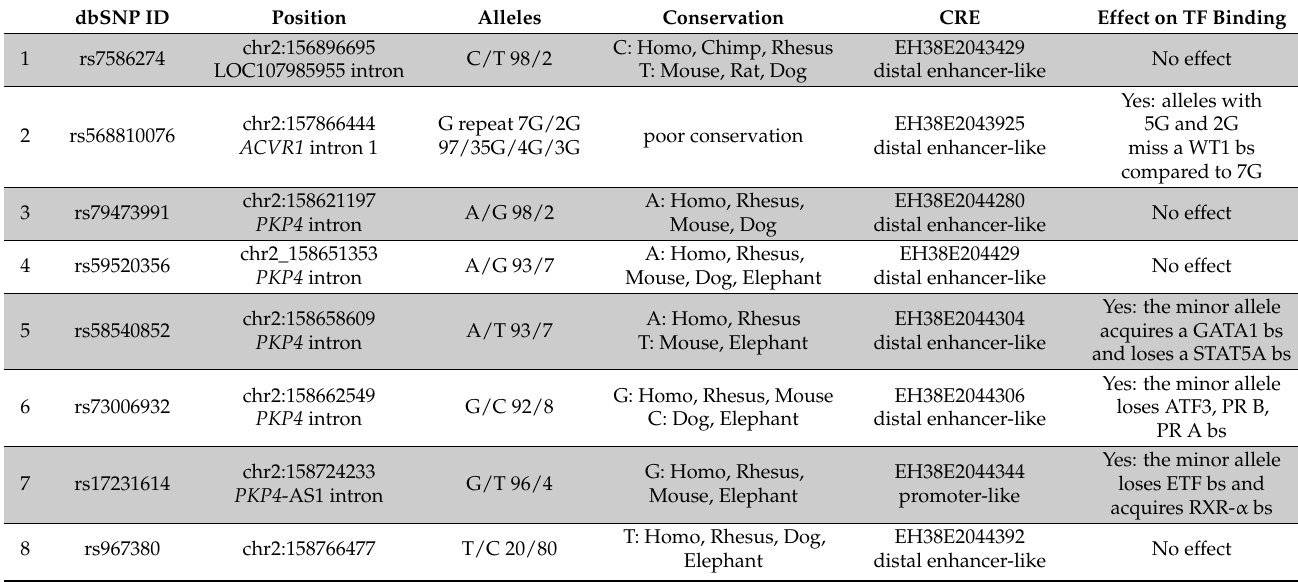
Table 1. List of the variants selected from the GTEx eQTLs affecting the expression of the ACVR1 gene and located inside a candidate cis -Regulatory Region